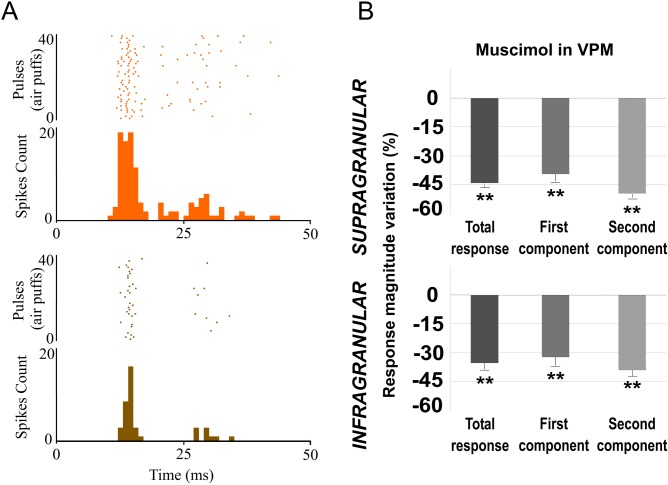
Muscimol-induced inactivation of the VPM.Inactivating VPM decreased responses in infra- and supragranular layers of S1. (A) Raster plots and PSTHs are shown for a supragranular sample neuron before (orange) and after (brown) VPM inactivation. (B) Mean response magnitude change (%) evoked by VPM inactivation. In both layers, spikes of sensory responses were strongly abolished after VPM inactivation by muscimol.